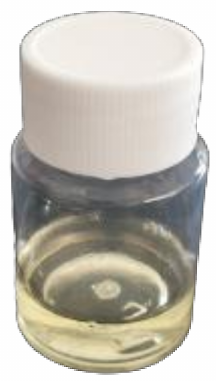
Figure 4. Appearance of TVi 7iso –POSS.